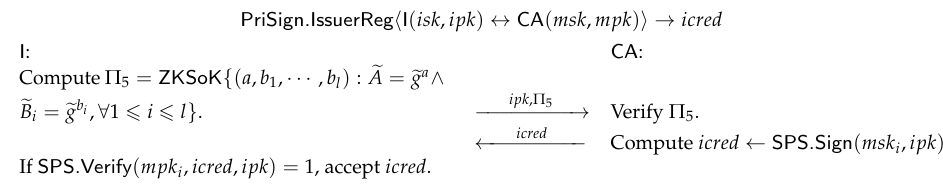
Figure 9. Issuer Registration